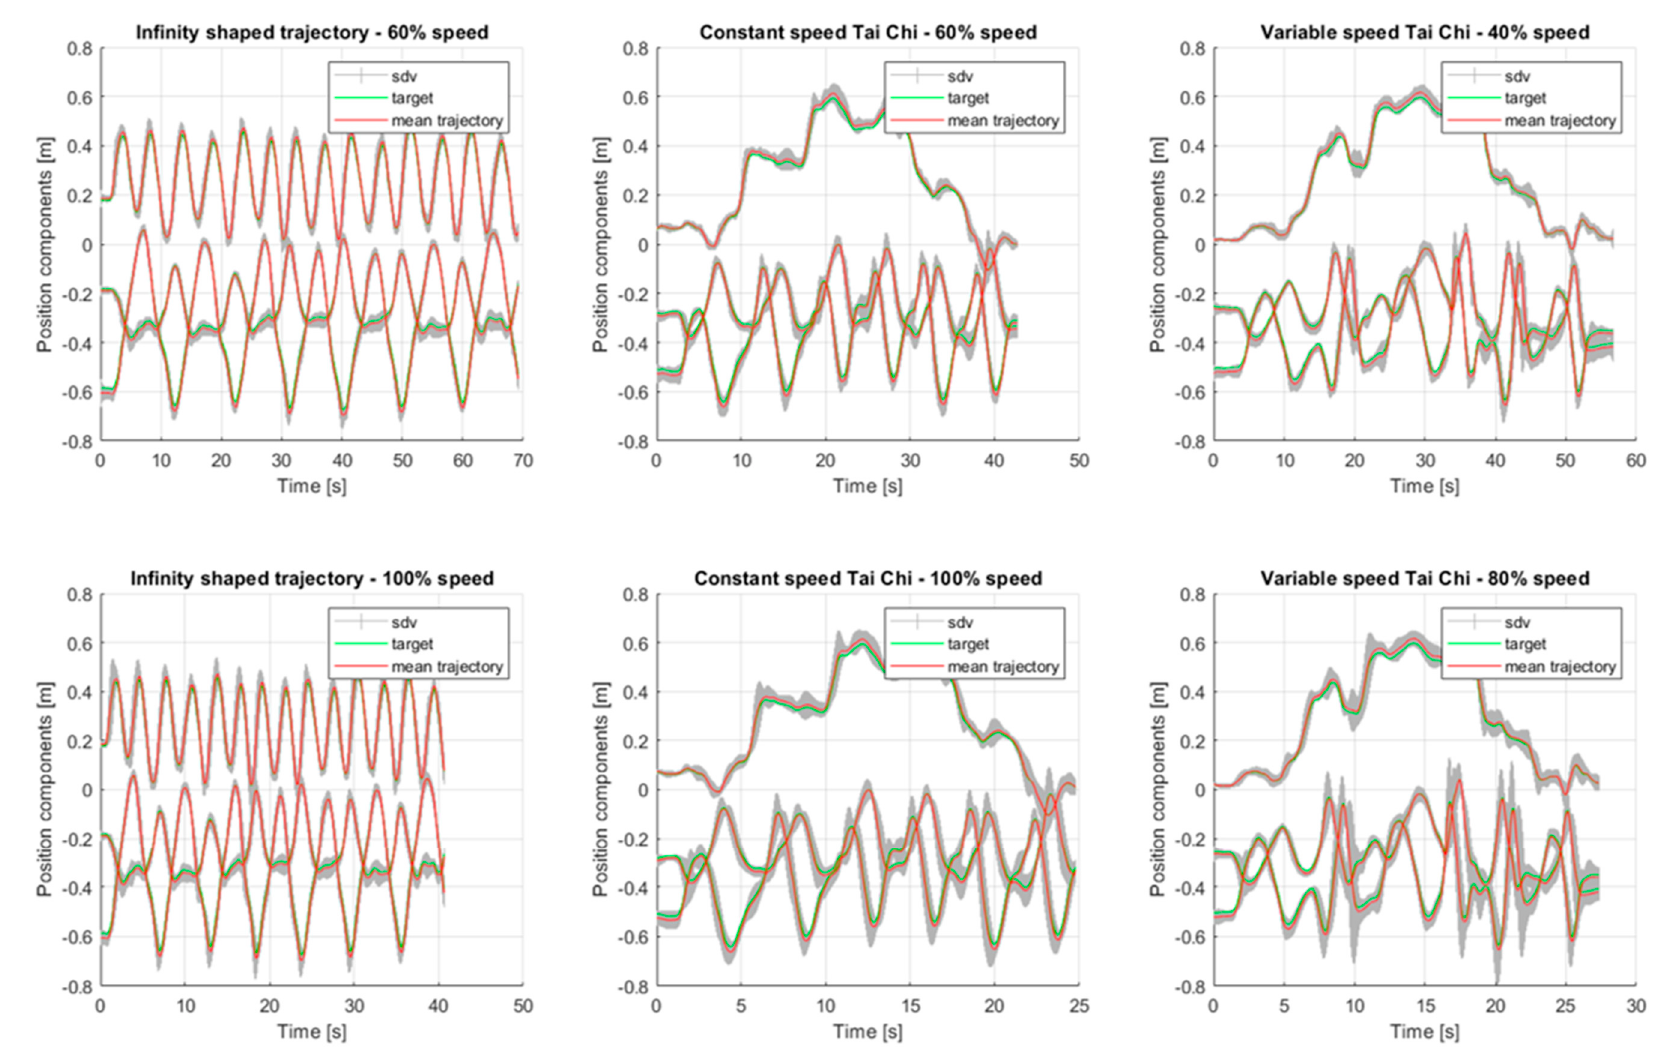
Figure A1. Average over all subjects and repetitions with standard deviation and target position.